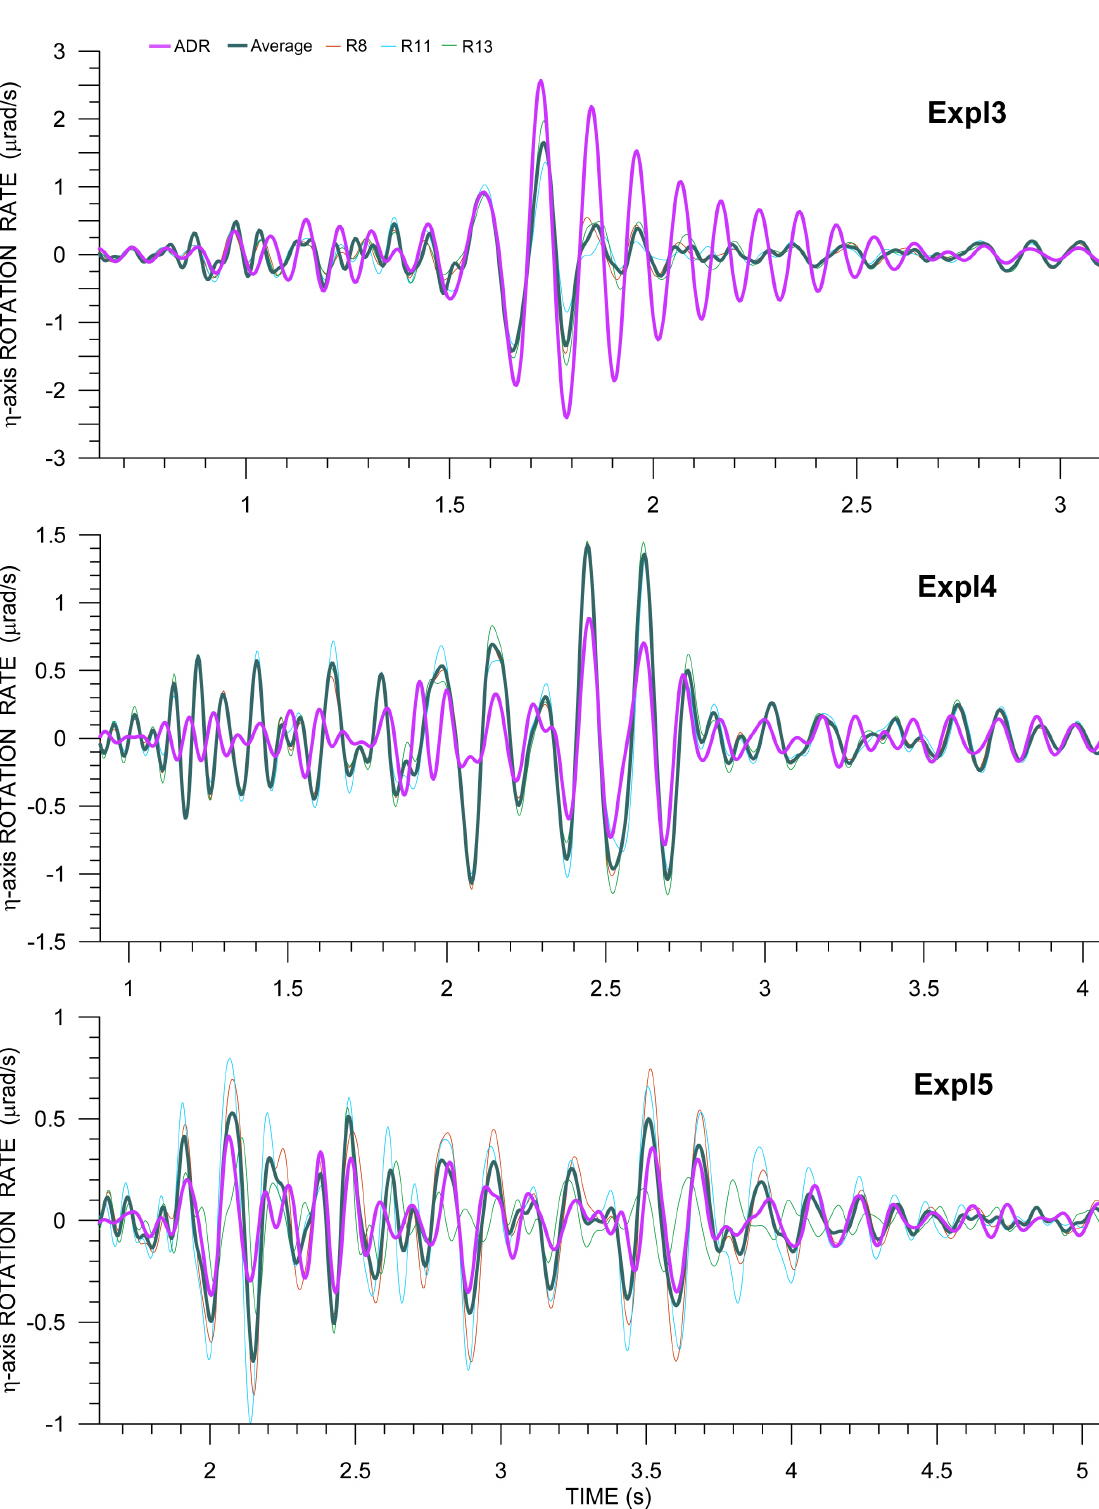
Figure 12. Comparison of array-derived rotation (ADR) transverse rotation rate (purple) with that from R8 (thin red), R11 (thin light blue), and R13 (thin green) and with the average transverse rotation (pine green) from those three instruments for explosions Expl3, Expl4, and Expl5. The transverse directions are perpendicular to the geometrical azimuths of 294 ◦ (Expl3), 293 ◦ (Expl4), and 285 ◦